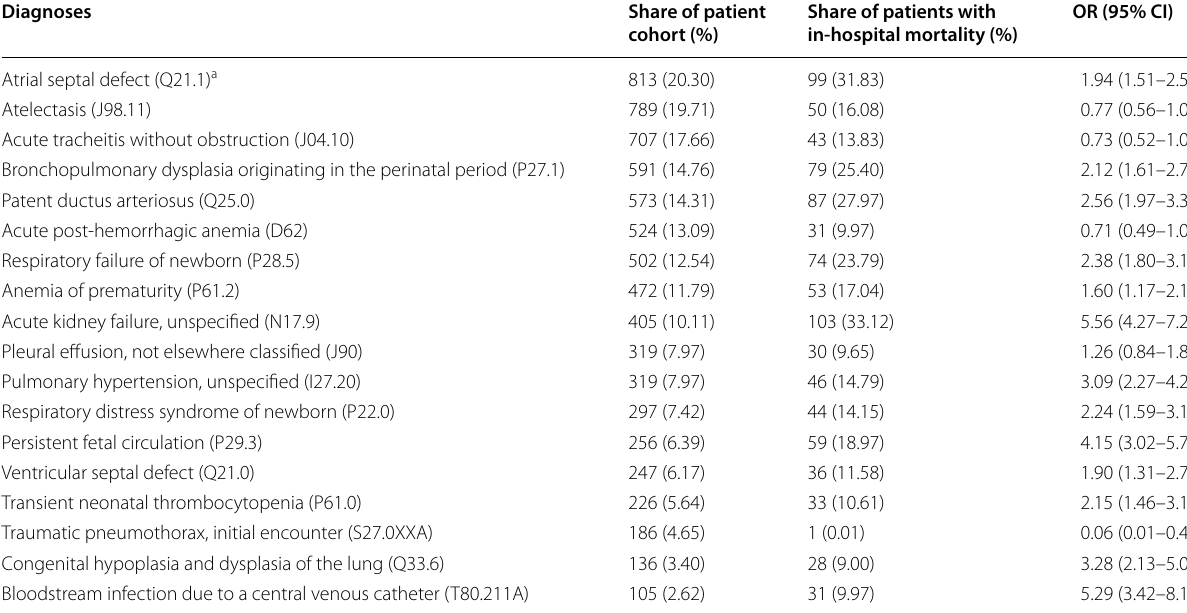
Table 3 Prevalence of comorbidities in OT patients and their association with in-hospital mortality using OR analysis